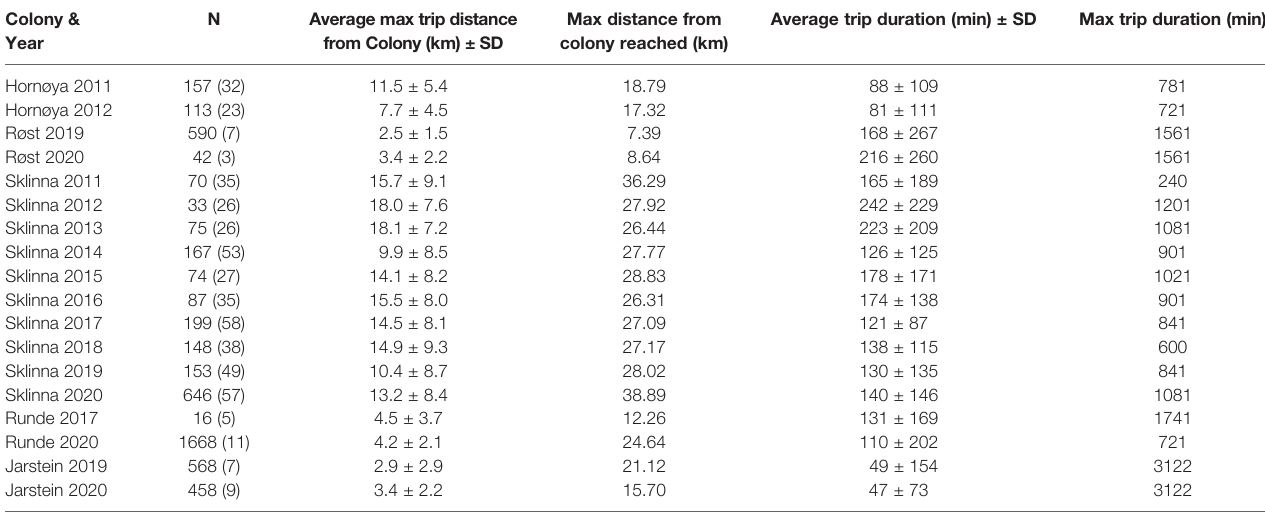
TABLE 1 | Foraging trip metrics per colony and year obtained from complete foraging trips (see Methods). Colony & N Average max trip distance Max distance from Year from Colony (km) ± SD colony reached